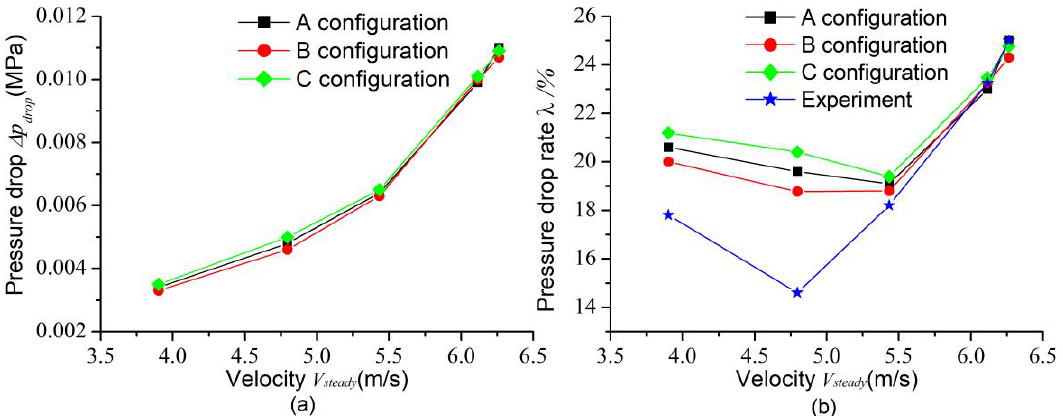
Figure 17. Influence of inlet stability velocity on the pressure drop: ( a ) pressure drop; ( b ) pressure drop rate.